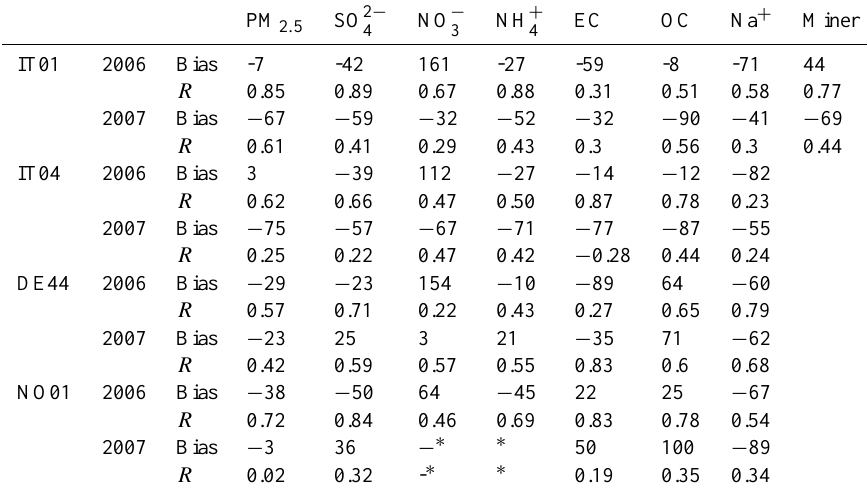
Table 4. Comparison statistics between model calculations and observations for PM 2 . 5